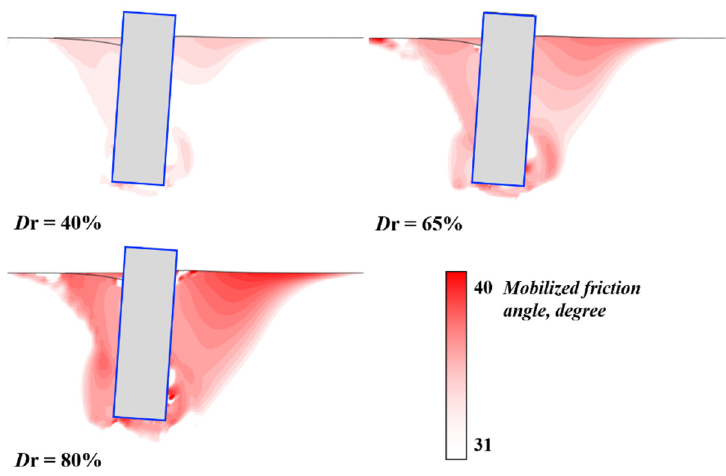
Figure 20. Mobilized friction angle contour of typical 10 m monopiles in loose, medium dense and dense sand at a pile rotation of 4 degrees. dense sand at a pile rotation of 4